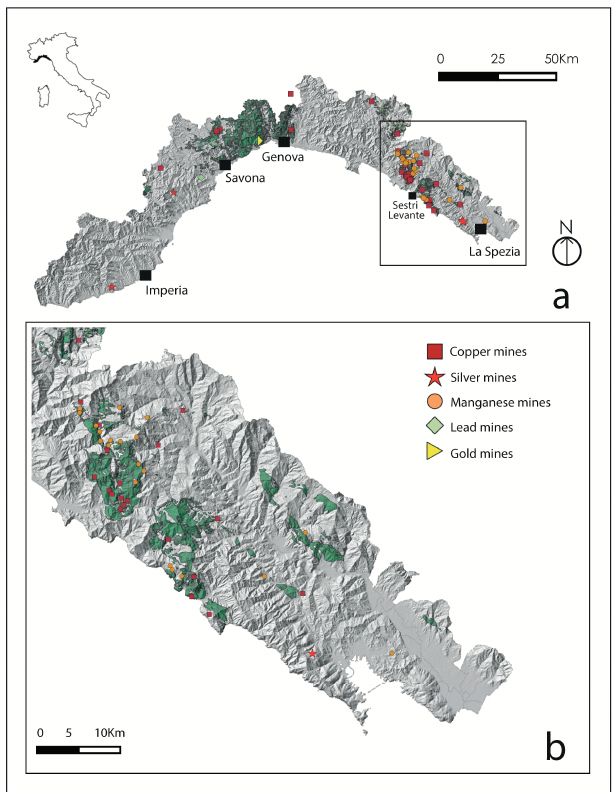
Figure 1. ( a ) Location of the main abandoned mines of Liguria; ( b ) expanded view of eastern Liguria mine occurrence. Green areas represent ophiolite exposures. Geological map supplied as Open Data by the Liguria Regional Government [41]